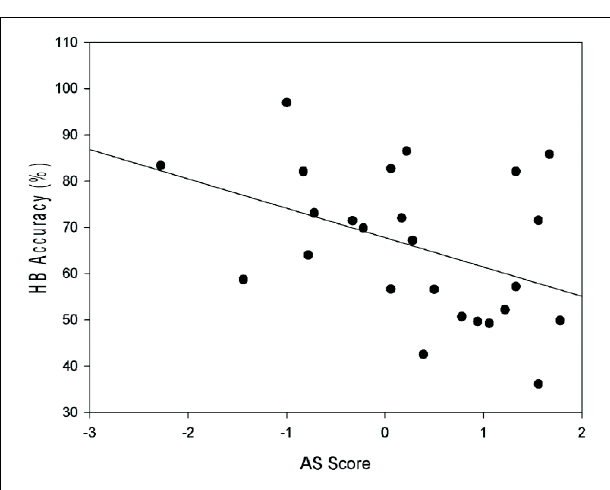
FIGURE 2 |The relationship betweenAS Score and heartbeat accuracy score (%; HBAccuracy), r = − 0.43, p =